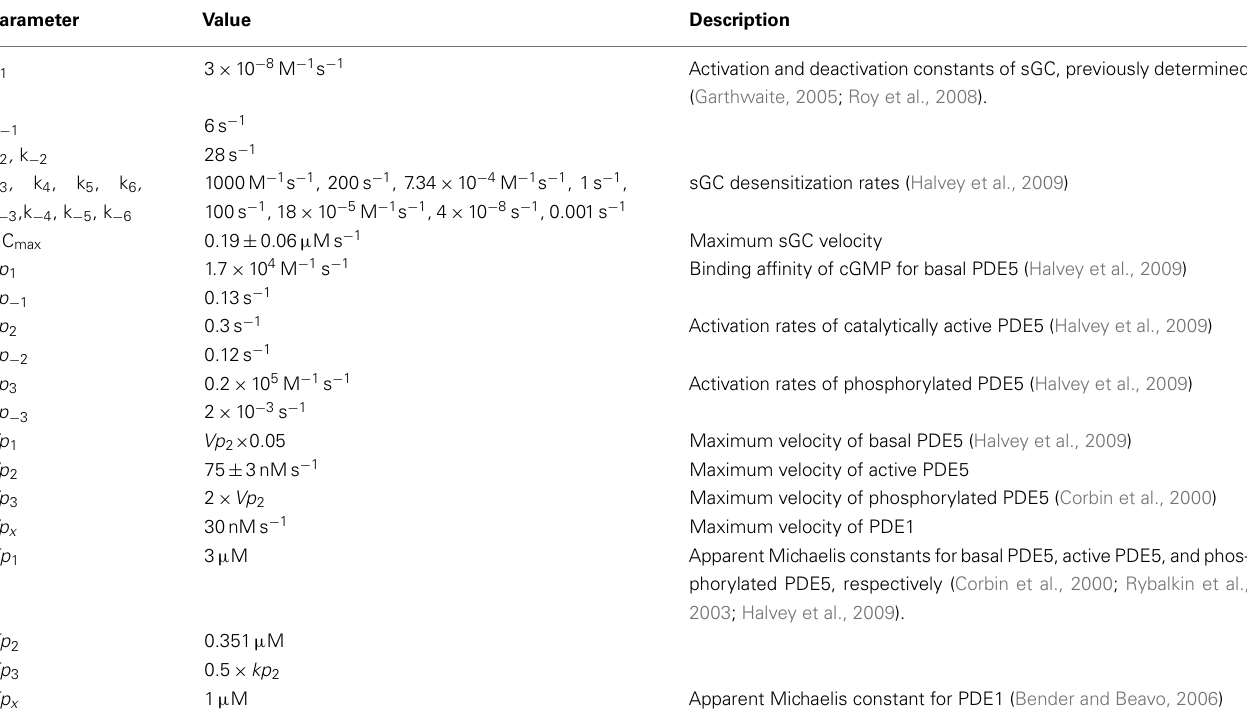
Table 3 |The mathematical model parameters and